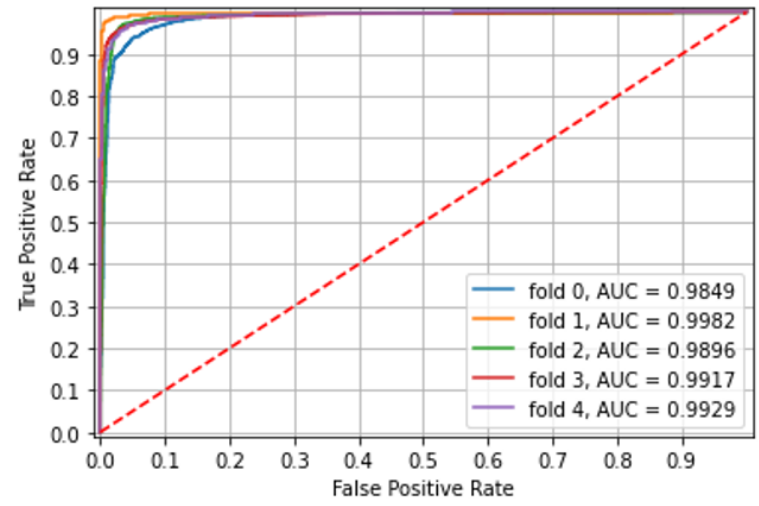
( b ) Figure 2. Experiment 2: ( a ) Classification of PillCam Crohn CE images by a model trained on Pill- Cam SB3 CE images ( b ) Classification of PillCam SB3 CE images by a model trained on PillCam Crohn CE images. Experiment 3: Combined model The model was trained and tested on a combined dataset of CE images from both capsule types and achieved excellent accuracy in the identification of ulcerated mucosa with an area under the curve (AUC) of over 0.98. Over five different folds, with non-over- lapping patients in each, the ROC AUC, accuracy, and mean patient accuracy are pre- sented in Table 3 and shown in Figure 3. Table 3. Classification of PillCam Crohn CE images by a combined model. Fold